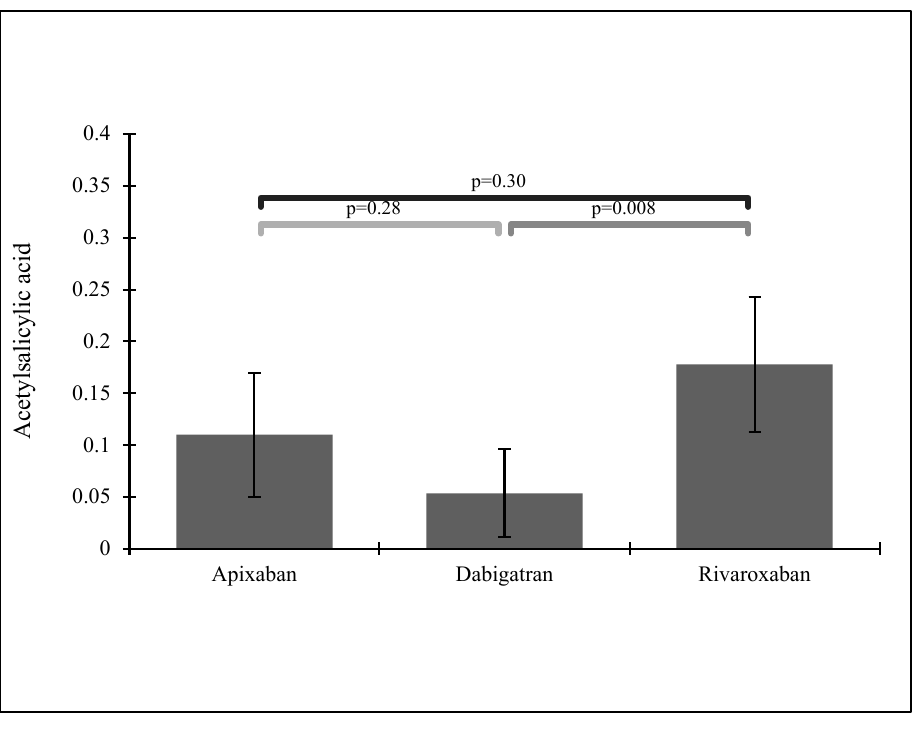
Figure 4. NOAC administration in patients with a previous stroke history while taking ASA.